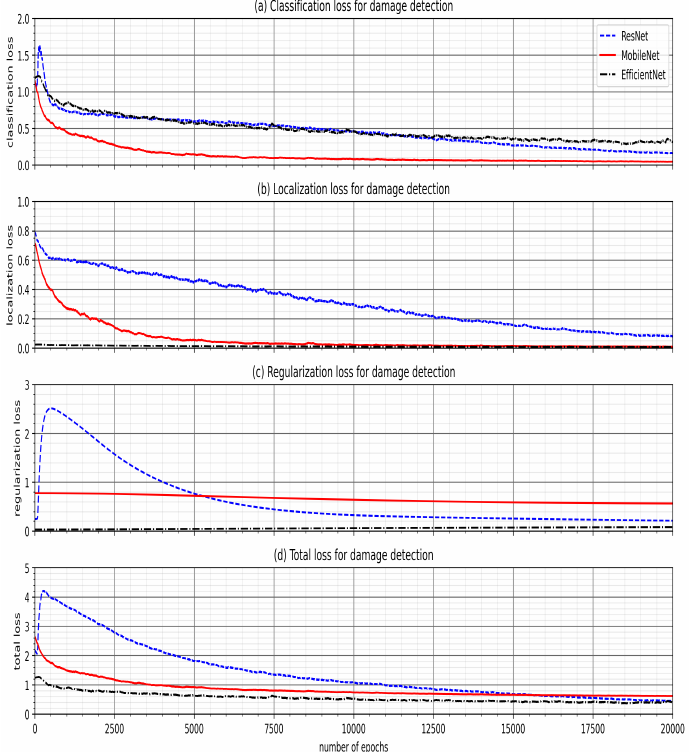
Figure 4. The training metrics for damage detection using classification loss, localization loss, regularization loss, and total loss up to the twenty-thousandth (20 k)